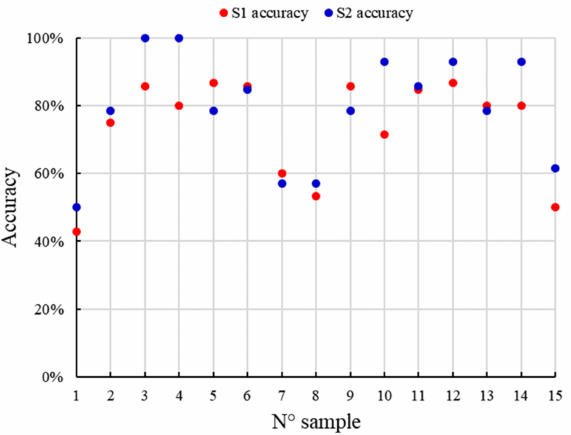
Figure 20. Geometric verification accuracy for each S1 and S2 image set of the foot.